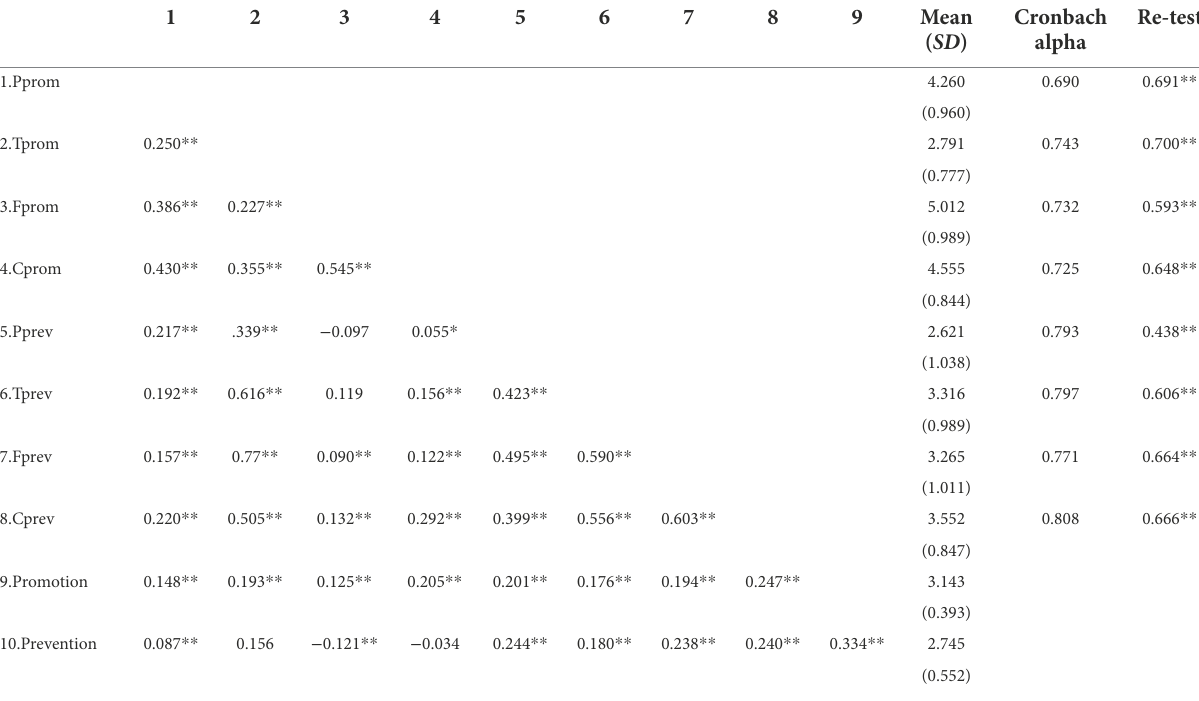
TABLE 4 Correlations, descriptive statistics of promotion-prevention focus in relationships and general regulatory focus, and reliability test, re-test reliability for